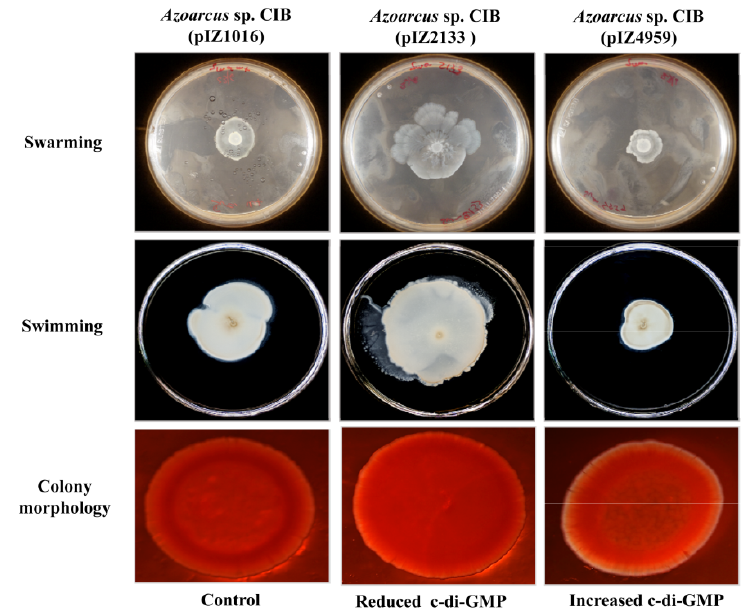
Figure 4. Motility and morphology of the colonies of Azoarcus sp. CIB strains expressing genes involved in the metabolism of c-di-GMP. The plates were inoculated with Azoarcus sp. CIB (pIZ1016) (empty plasmid), Azoarcus sp. CIB (pIZ2133) (expressing the PA2133 phosphodiesterase) and Azoarcus sp. CIB (pIZ4959) (expressing the PP4959 diguanylate cyclase). To analyze whether the altered levels of c-di-GMP in Azoarcus sp. CIB (pIZ2133) and Azoarcus sp. CIB (pIZ4959) strains might influence their plant colonization abilities, rice seedlings colonization tests were performed. As shown in Figure 5, the number of endophytes recovered from seedlings inoculated with Azoarcus sp. CIB (pIZ2133) cells (1.46 × 10 3 bacteria per g of root), was more than one order of magnitude lower than the number of endophytes recovered after inoculation with the CIB control strain (2.5 × 10 4 bacteria per g of root). On the other hand, inoculation with the strain Azoarcus sp. CIB (pIZ4959) led to 7.63 × 10 3 endophytes per g of root, which represents a loss of